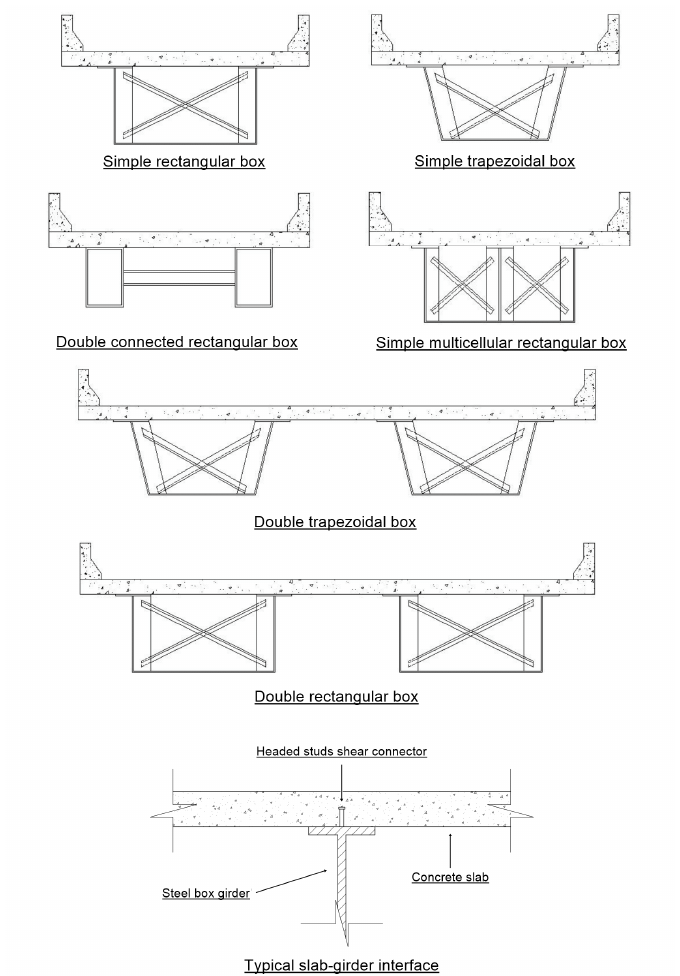
Figure 1. Examples of steel-concrete composite box girder bridges. Adapted from Pinho and Bellei